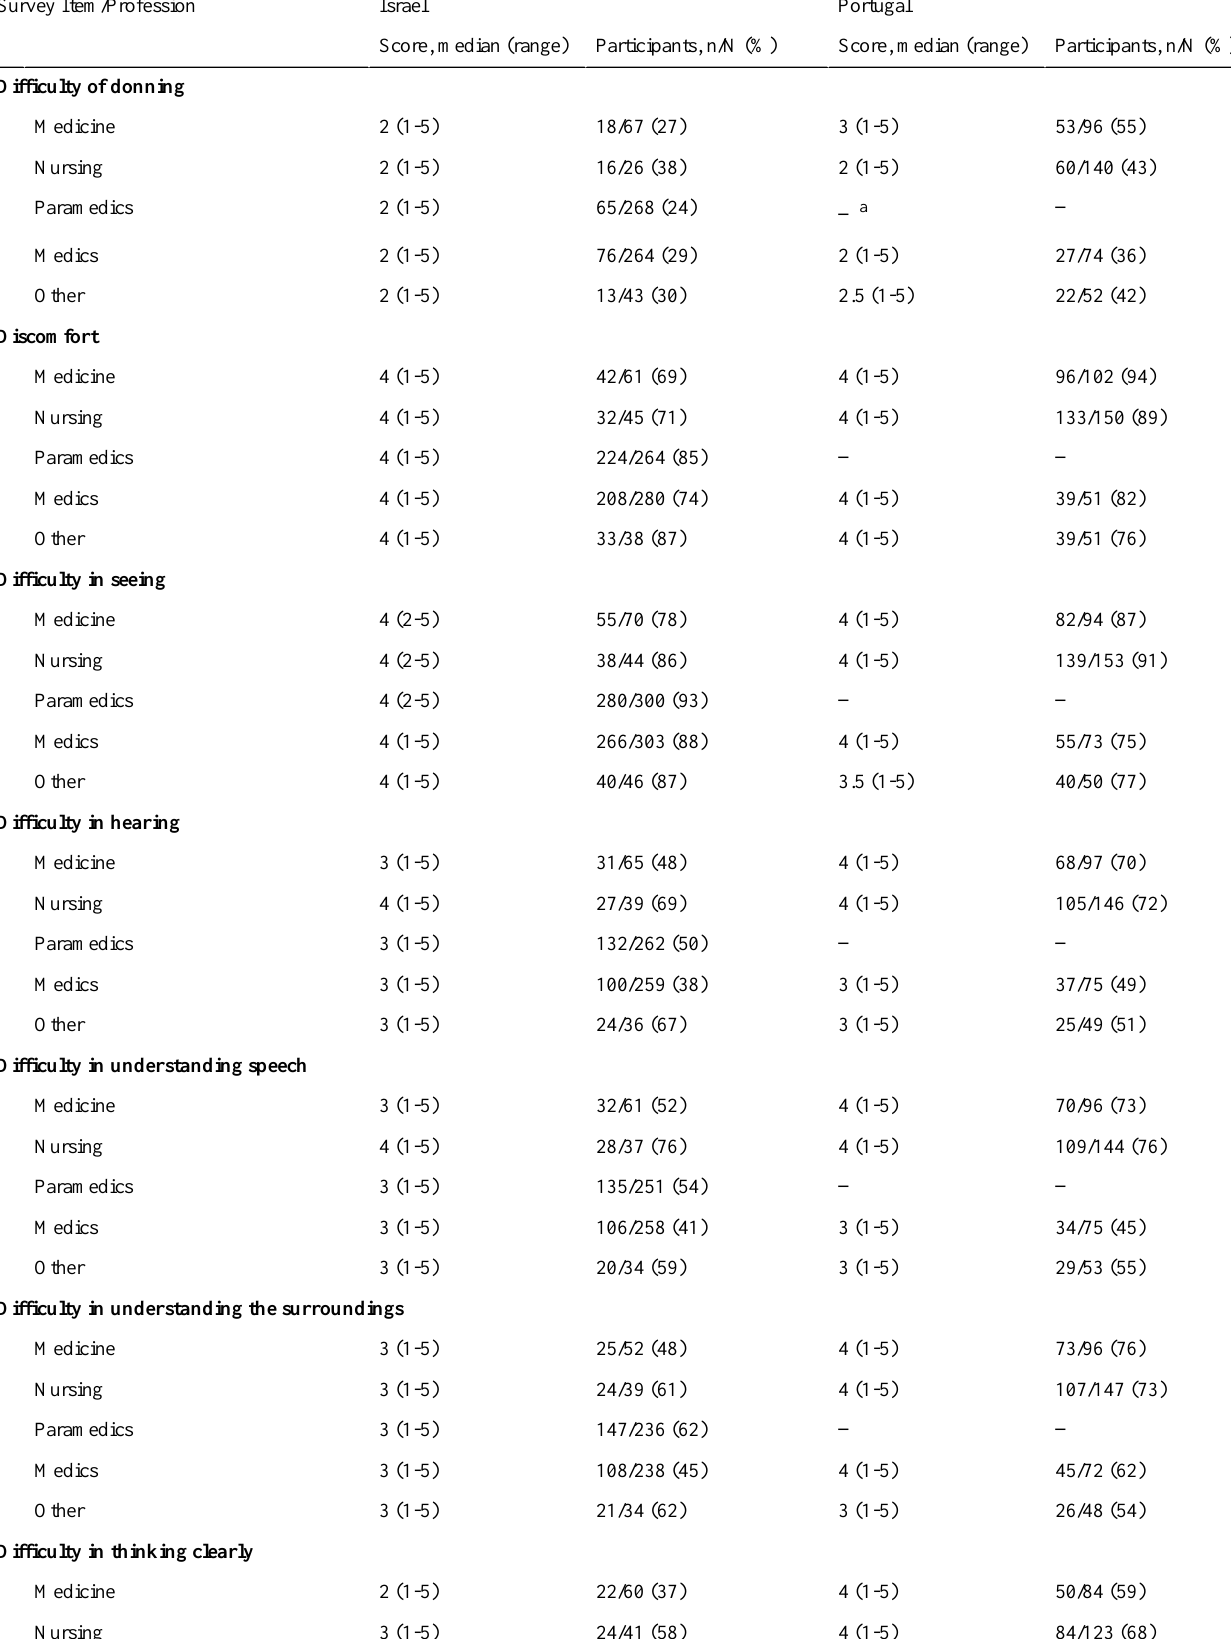
Table 2. Medians for each of the survey items, together with the proportions of respondents who agreed and strongly agreed with the difficulty, stratified by profession, for each of the